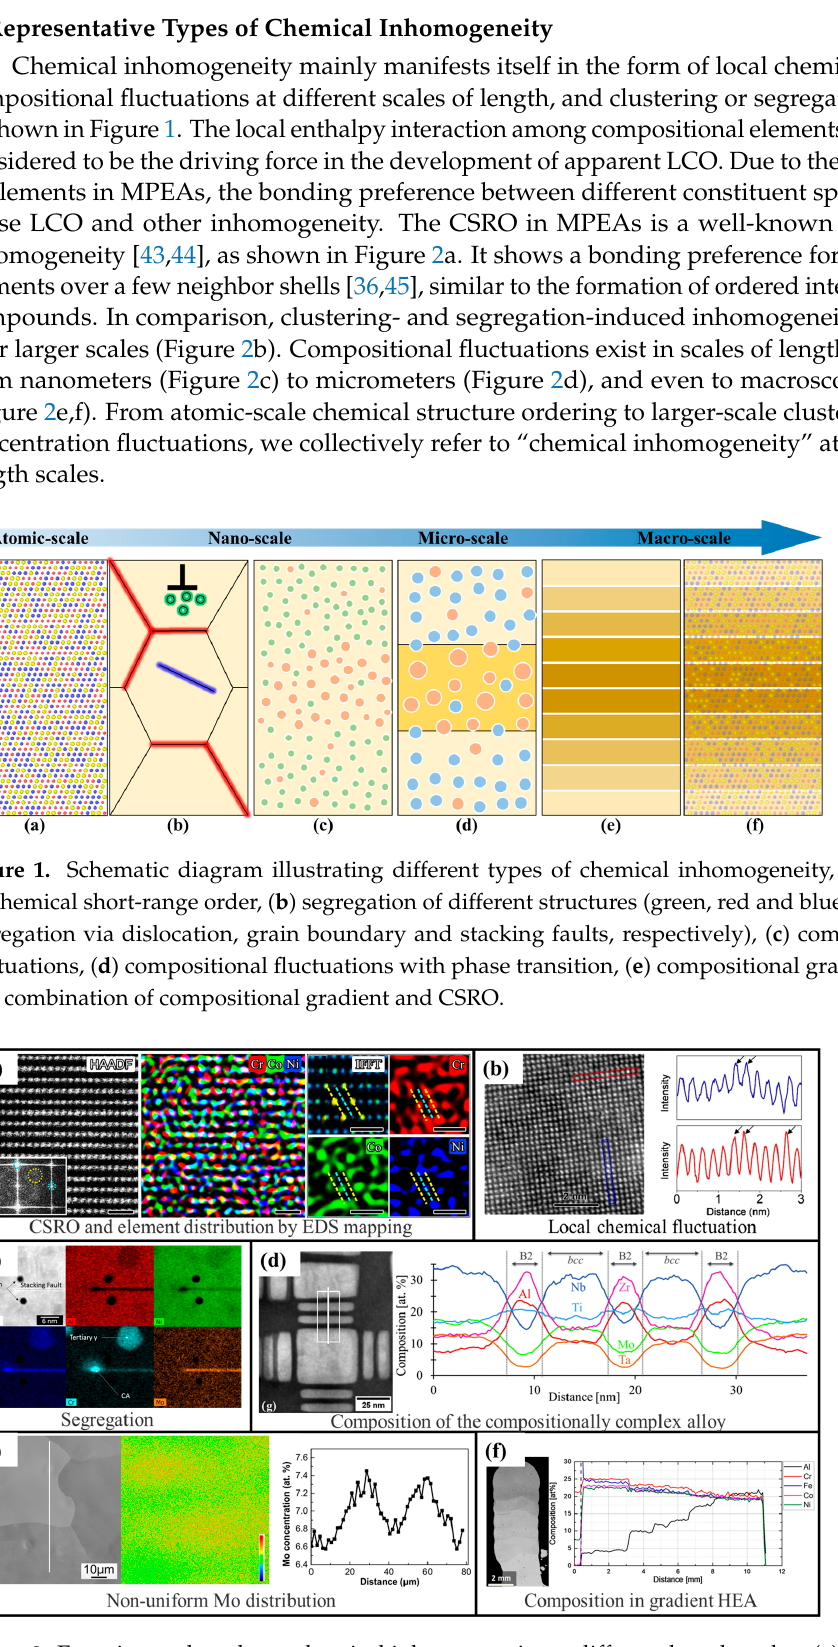
Figure 2. Experimental study on chemical inhomogeneity at different length scales. ( a ) Chemical short-range order region and element distribution by EDS mapping (Reprinted with permission from Ref. [44]. Copyright 2022, Elsevier); ( b ) nanoscale compositional fluctuation: HAADF − STEM image and the corresponding intensity line profiles of the blue and red squared regions (Reprinted with permission from Ref. [46]. Copyright 2021, Elsevier); ( c ) segregation via stacking faults (Re- printed with permission from Ref. [47]. Copyright 2018, Springer Nature); ( d ) nanoscale composi- tional fluctuation with phase transition (Reprinted with permission from Ref. [48]. Copyright 2016, Elsevier); ( e ) microscale compositional fluctuations (Reprinted with permission from Ref. [49]. Cop- yright 2019, Elsevier); ( f ) macroscale compositional gradient in NiCoFeCrAl HEA (Reprinted with permission from Ref. [50]. Copyright 2020, Frontiers). Experimental methods for the detection of local chemical order in MPEAs have been developed in recent years. Compositional inhomogeneity is first detected in the form of CSRO by extended X-ray absorption fine structure (EXAFS). Laser irradiation is utilized to increase the degree of CSRO, and CSRO is qualitatively determined through data anal- ysis. In order to quantitatively describe the CSRO in MPEAs, more advanced methods are needed to be able to explore the complex atomic occupancy between different elements. High-angle annular dark field scanning transmission electron microscopy (HAADF- STEM) is a method suitable for analyzing the microstructure and performing composi- tional analysis of atom columns and even single atoms in alloys [51]. Niu et al. identified the existence of non-uniform ordered nano-domains throughout NiFeCrCo random solid solutions using HAADF-STEM measurements. Furthermore, three-dimensional atom probe tomography (3D-APT) supplemented by computational simulations enables the de- scription of CSRO in real-space reconstructed 3D atomic images [52–54]. Recently, Zhang et al. [26] reported the observation of structural features of CSRO in CrCoNi MEA using energy-filtered electron diffraction and HAADF-STEM imaging. It is worth noting that CSRO theoretically only contains a few nearest neighbor atomic layers, but the above studies reveal the local chemical order at the nanometer scale. Therefore, experimental methods can reveal large-scale compositional inhomogeneity (>1 nm), but the characteri- zation of CSRO (<1 nm) remains difficult. In addition to experimental study, previous theoretical studies [29,31] have demon- strated that CSRO in MPEAs is thermo-dynamically favored and can be designed for the tuning of mechanical properties. Additionally, computational simulation methods are